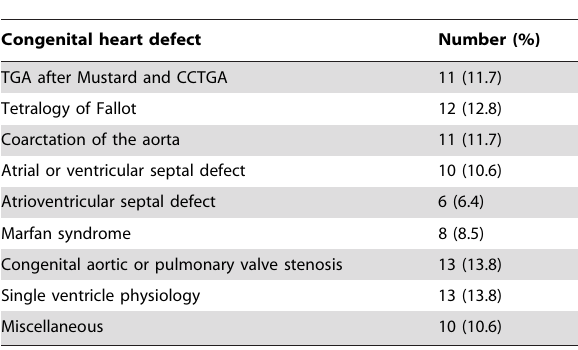
Table 2. Type of congenital heart defect.